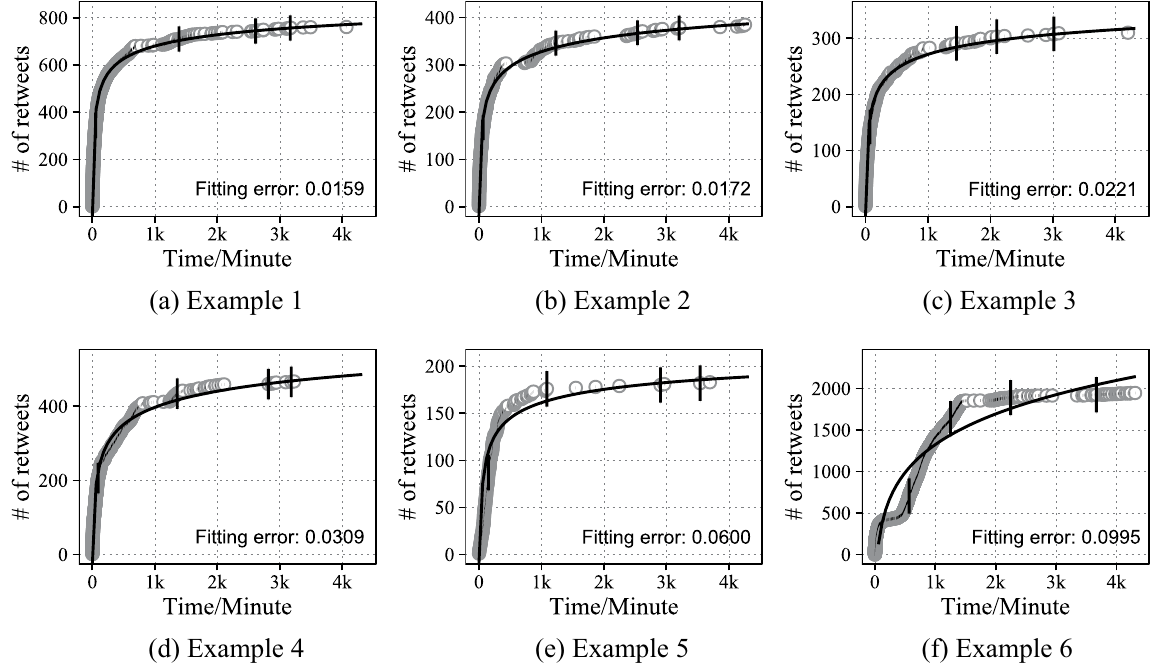
Figure 5. Model fitting examples with our real-world data set. The grey dots represent the cumulative numbers of retweets at different time points. And the black curves are the fitted models with the form of our power function. Error-bars are calculated based on the standard deviation of